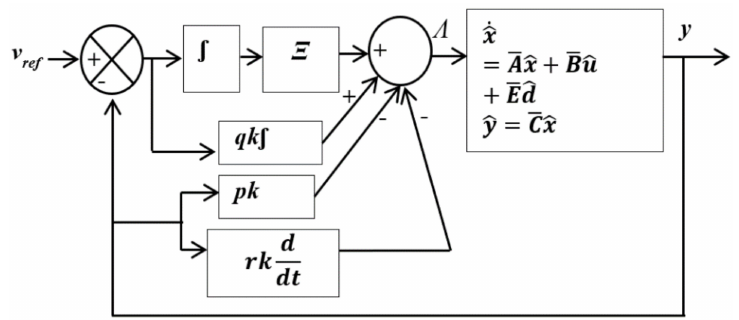
Figure 6. Block diagram representation of the multivariable PID